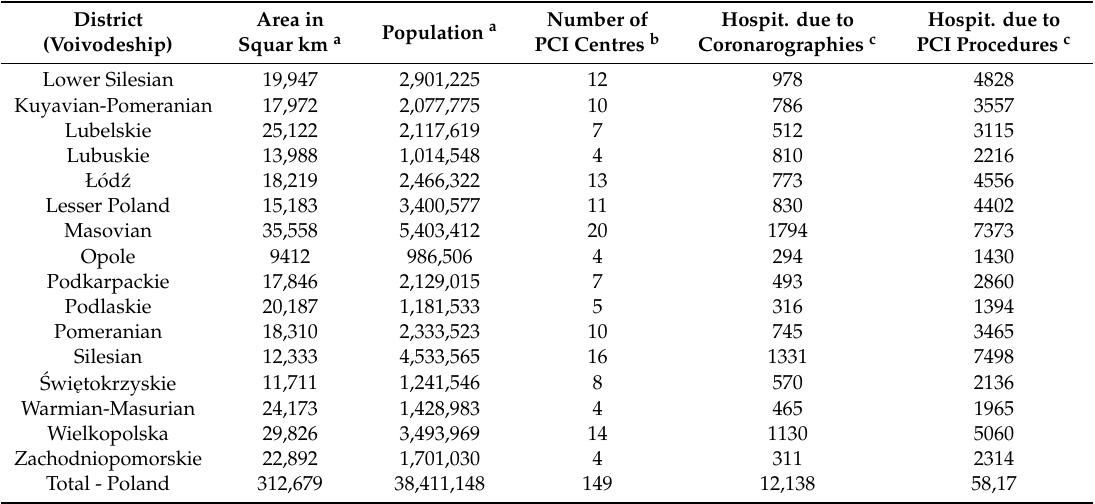
Table 1. Characteristics of Polish districts (voivodeships) as units of analysis. District